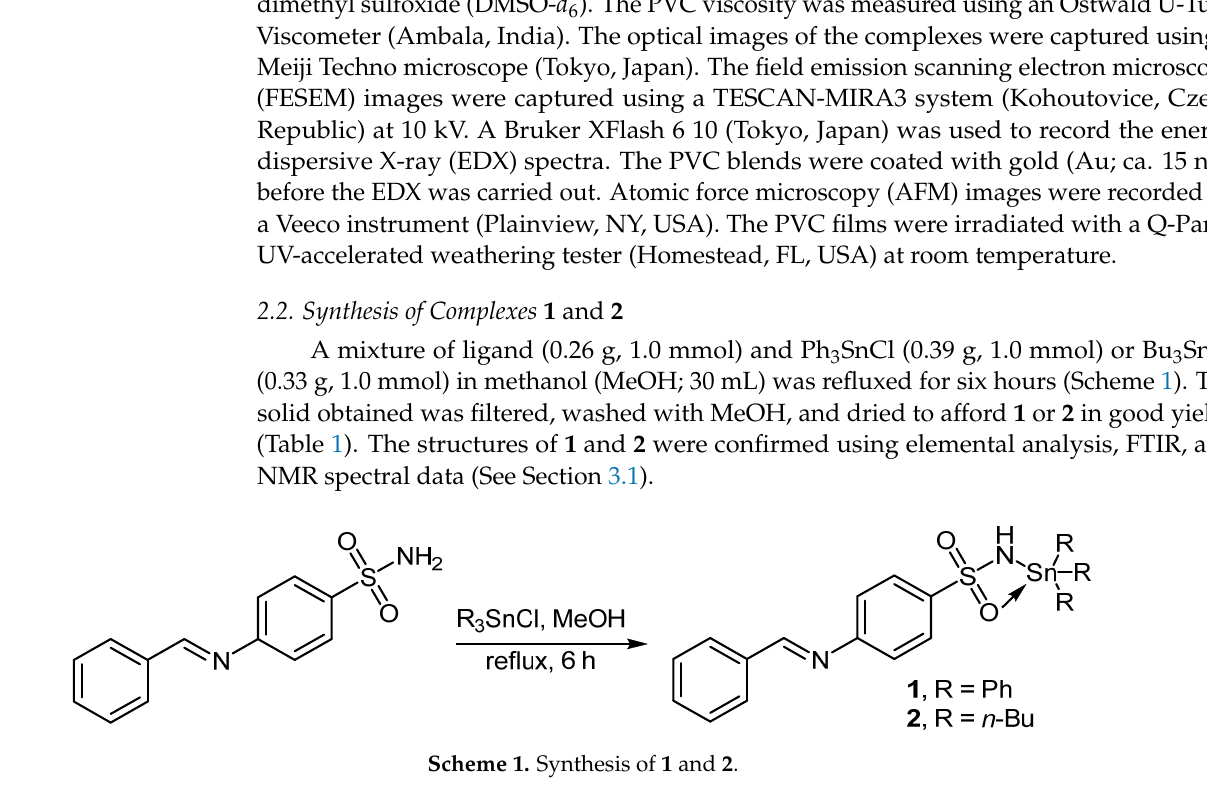
Table 1. Color, melting points, yields, and elemental composition of complexes 1 – 3